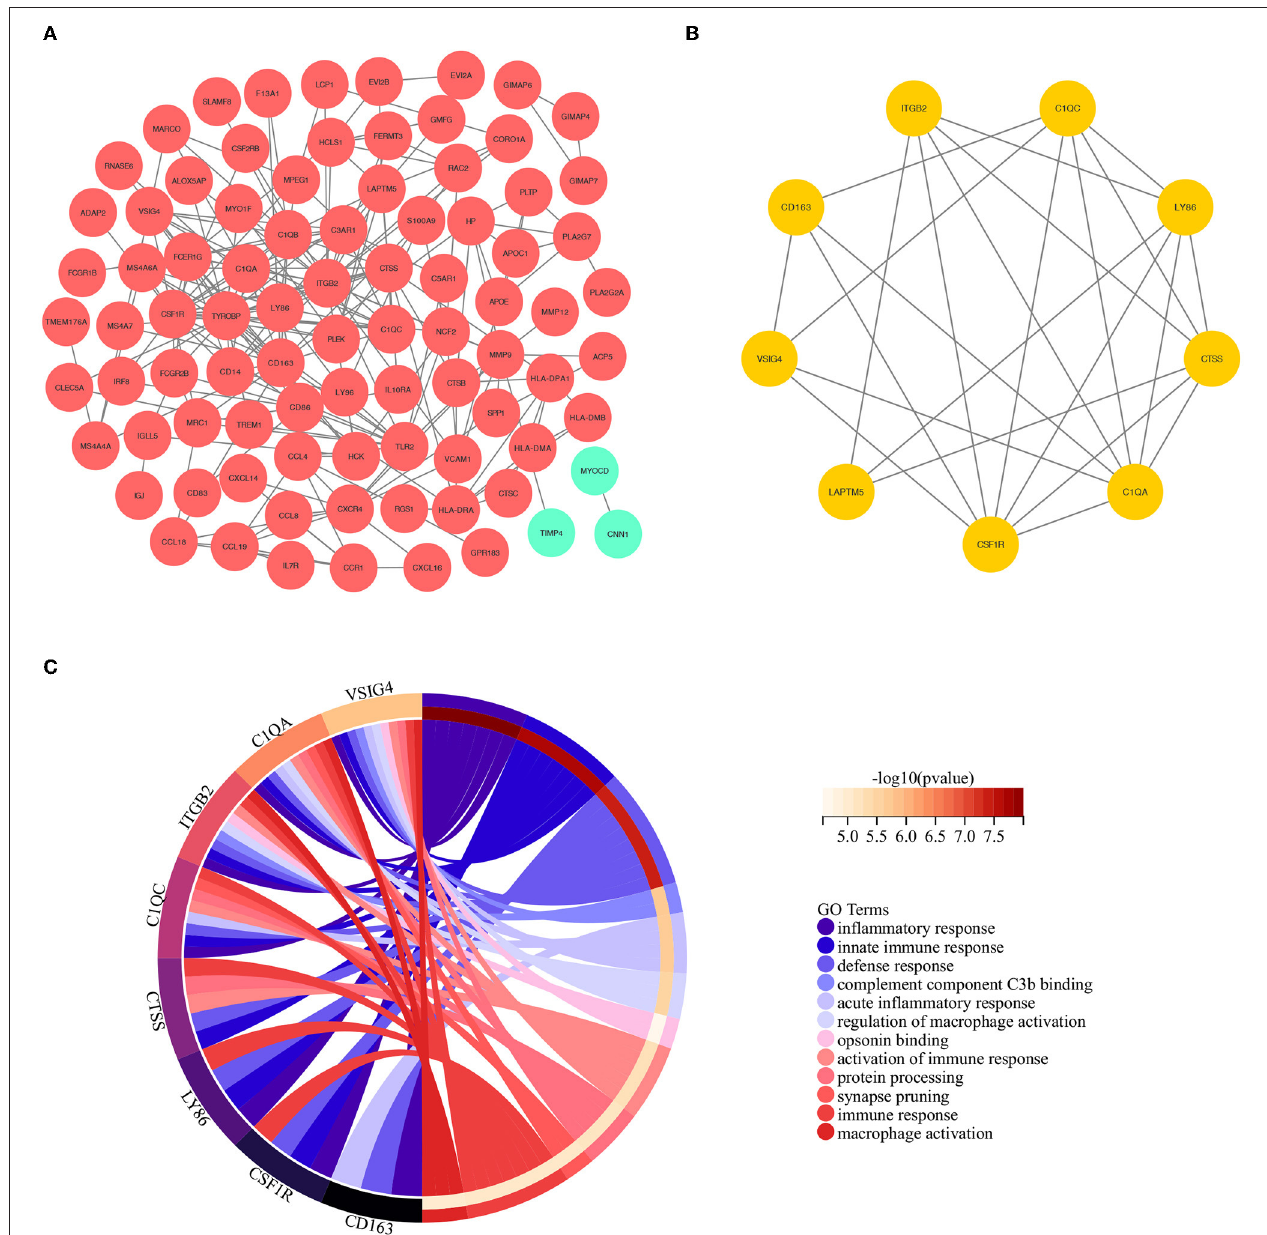
FIGURE 3 | (A) The construction of the PPI network based on the DEGs. The red ellipse represents up-regulated DEGs, the green ellipse represents down-regulated DEGs. (B) The cluster genes with the highest scores in the PPI network, displayed by the yellow ellipse. (C) The results of GO analysis based on the selected cluster